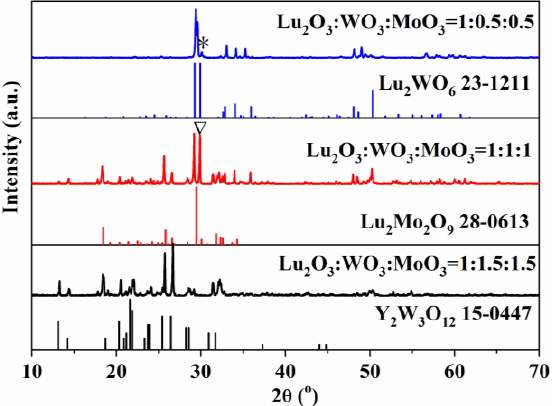
Figure 1. X-ray diffraction (XRD) patterns of phosphors synthesized at 1200 °C for 4 h and refer- ence data.